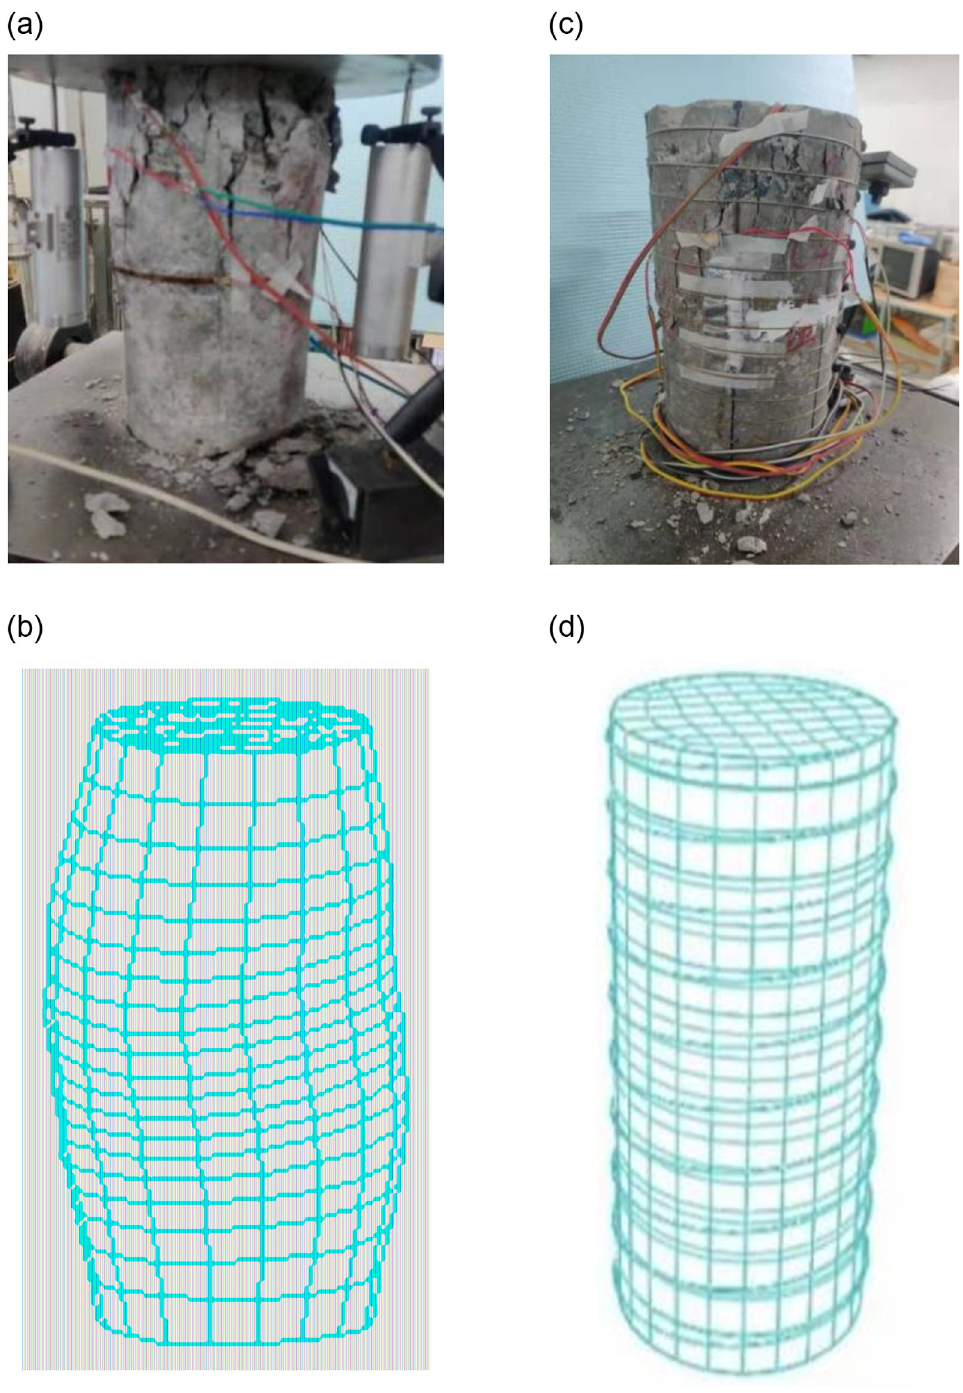
Fig 15. Comparison of specimen failure and deformation. (a)Test failure deformation. (b) Numerical simulation of deformation. (c)Test failure deformation. (d) Numerical simulation of deformation.